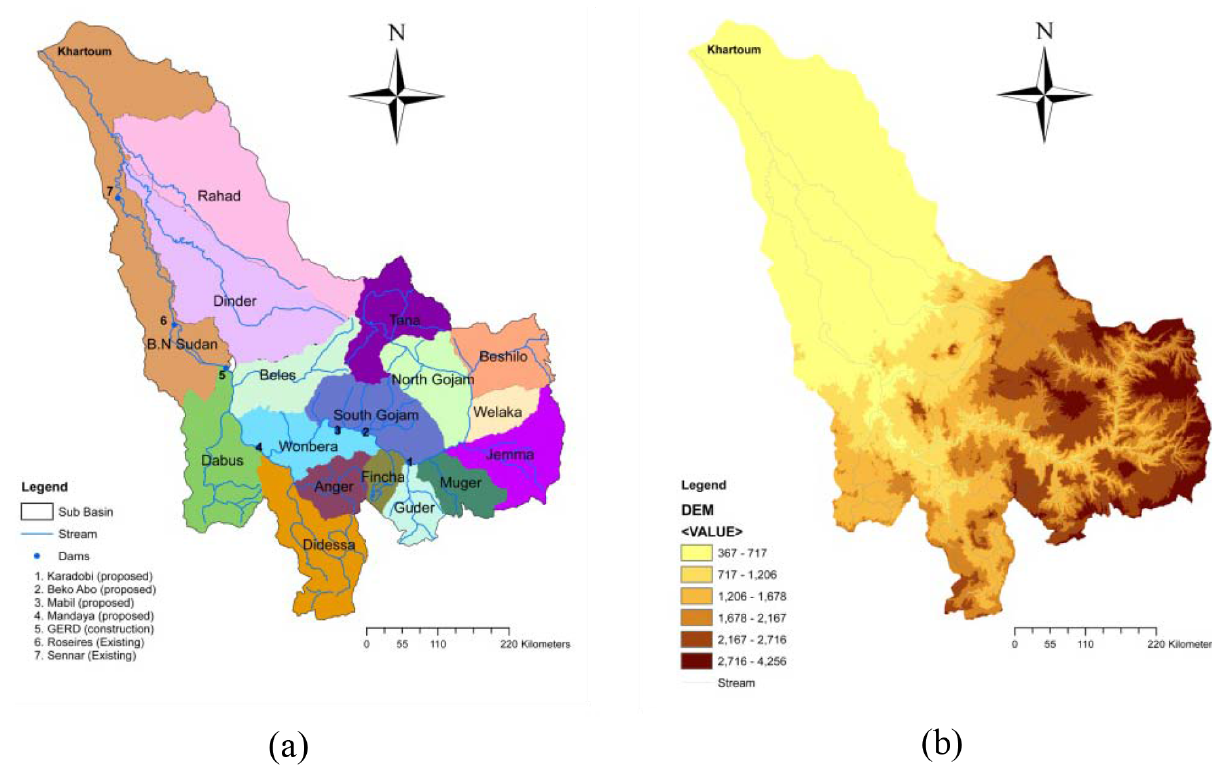
Figure 1. Blue Nile Basin and Roseires Dam. The elevation map was derived from STRM (90m) and is in ma.s.l. (WGS84